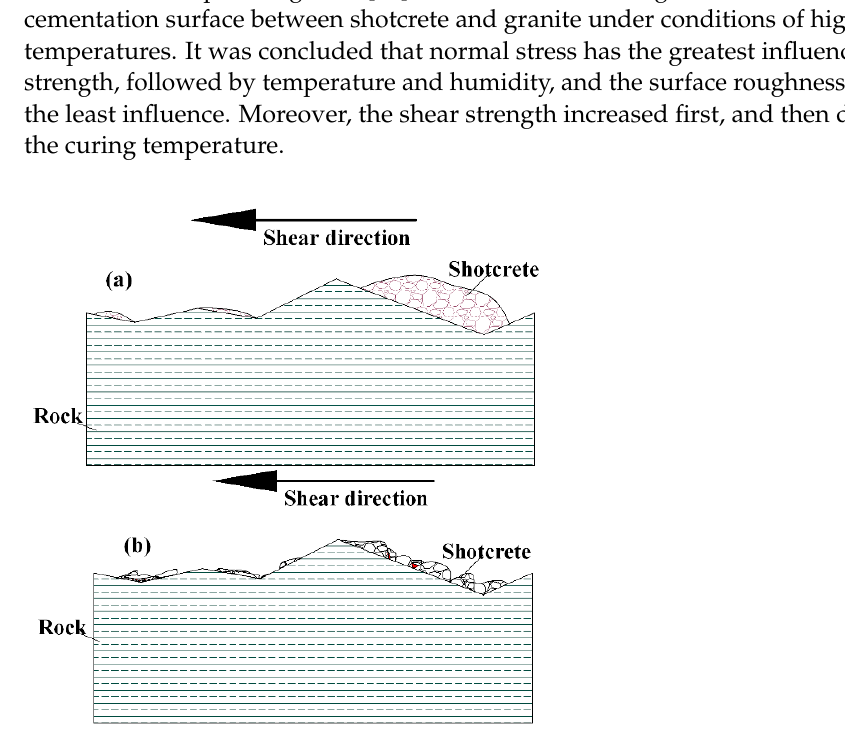
Figure 14. Shear failure model: ( a ) standard environment and ( b ) high temperature environment.